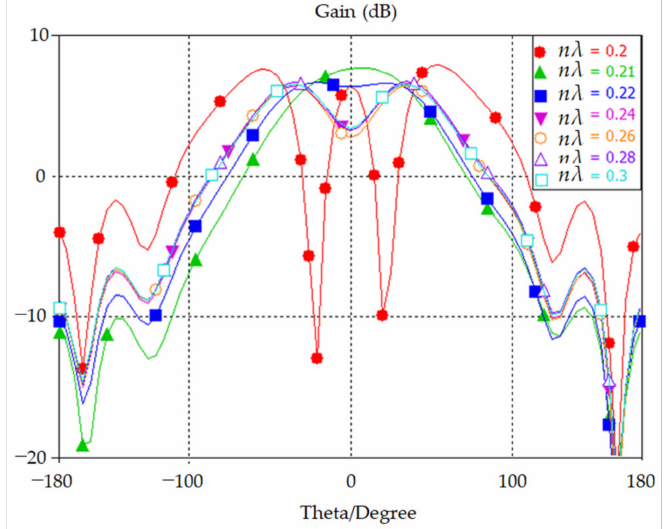
Figure 11. Simulated radiation pattern for different values of the gap between the parasitic patches ‘ a = b = n λ